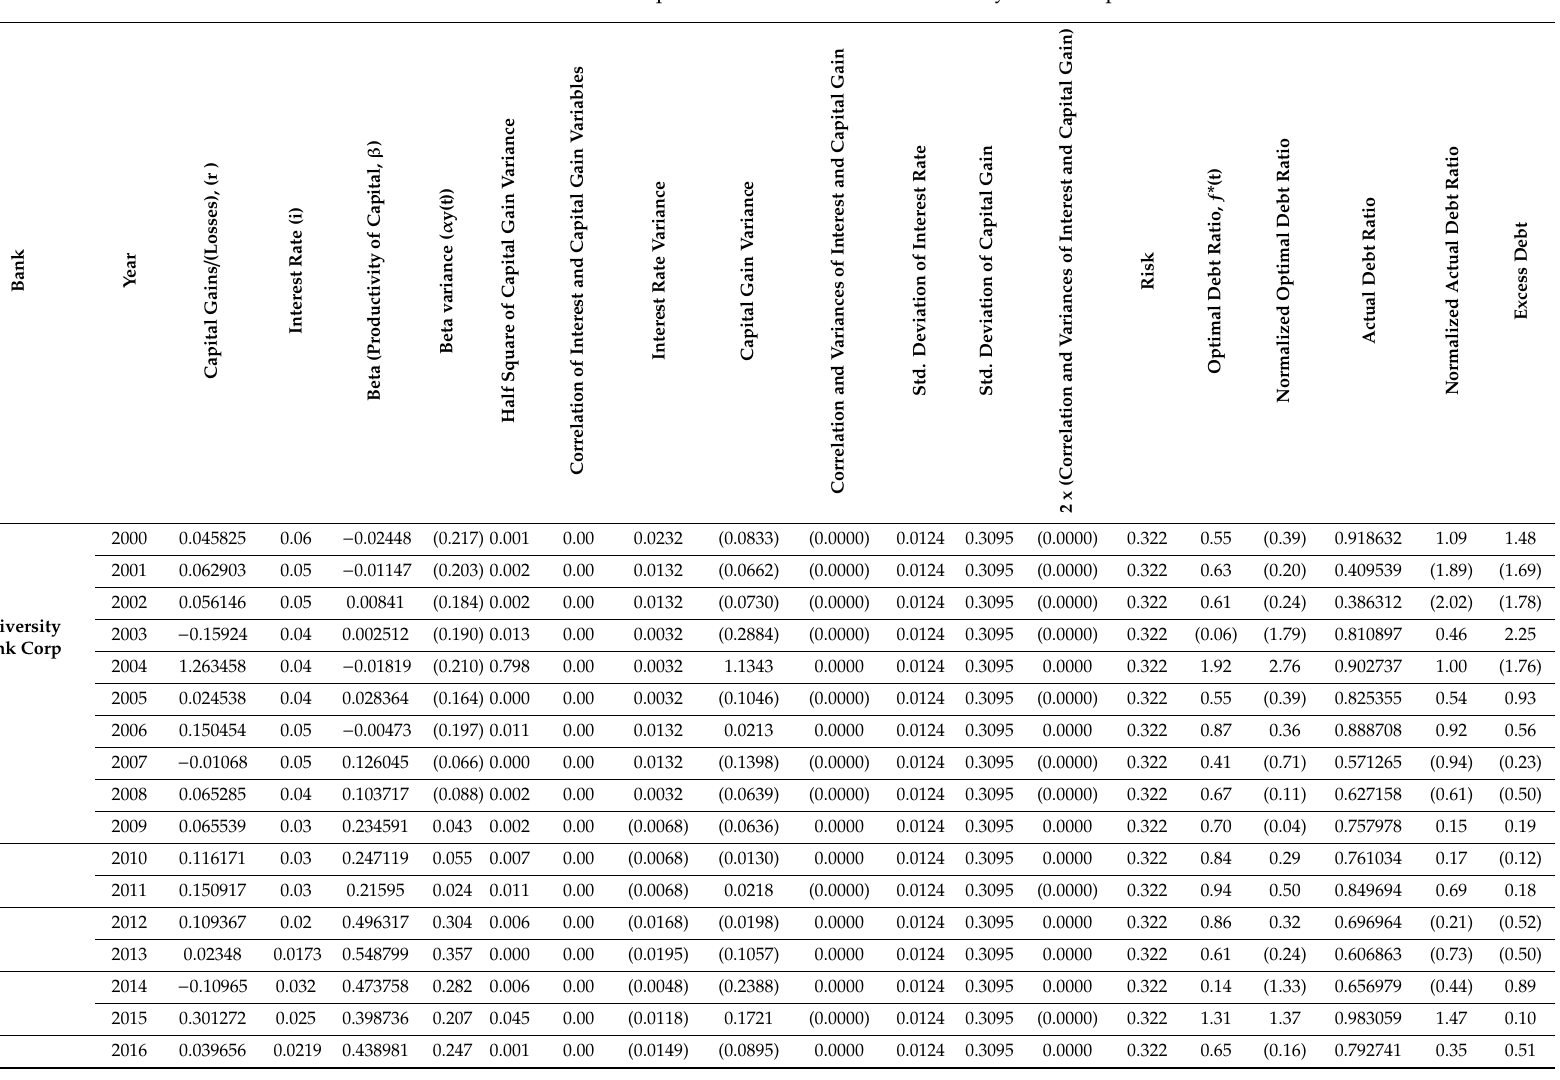
Table A17. Calculations of Optimal and Excess Debt: University Bank